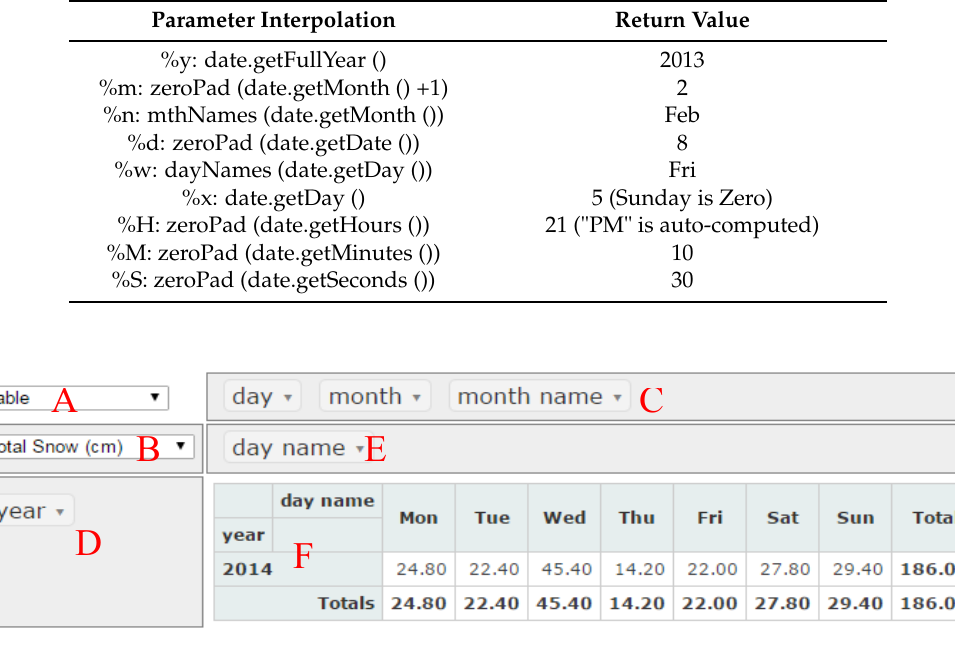
Figure A1. PivotTable Graphical User Interface (GUI). A to F represent function areas.